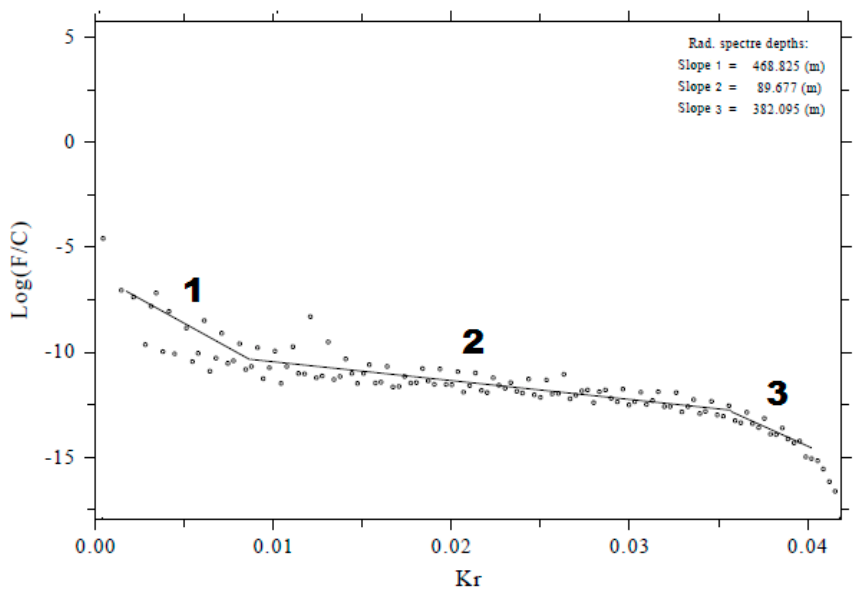
Figure 10. The 2D radial spectrum of complete Bouguer anomaly in Suli and Tulehu geothermal areas. Point 1 showed the slope of deep-seated sources, point 2 showed the shallow-seated sources, and point 3 showed the noise of the data.